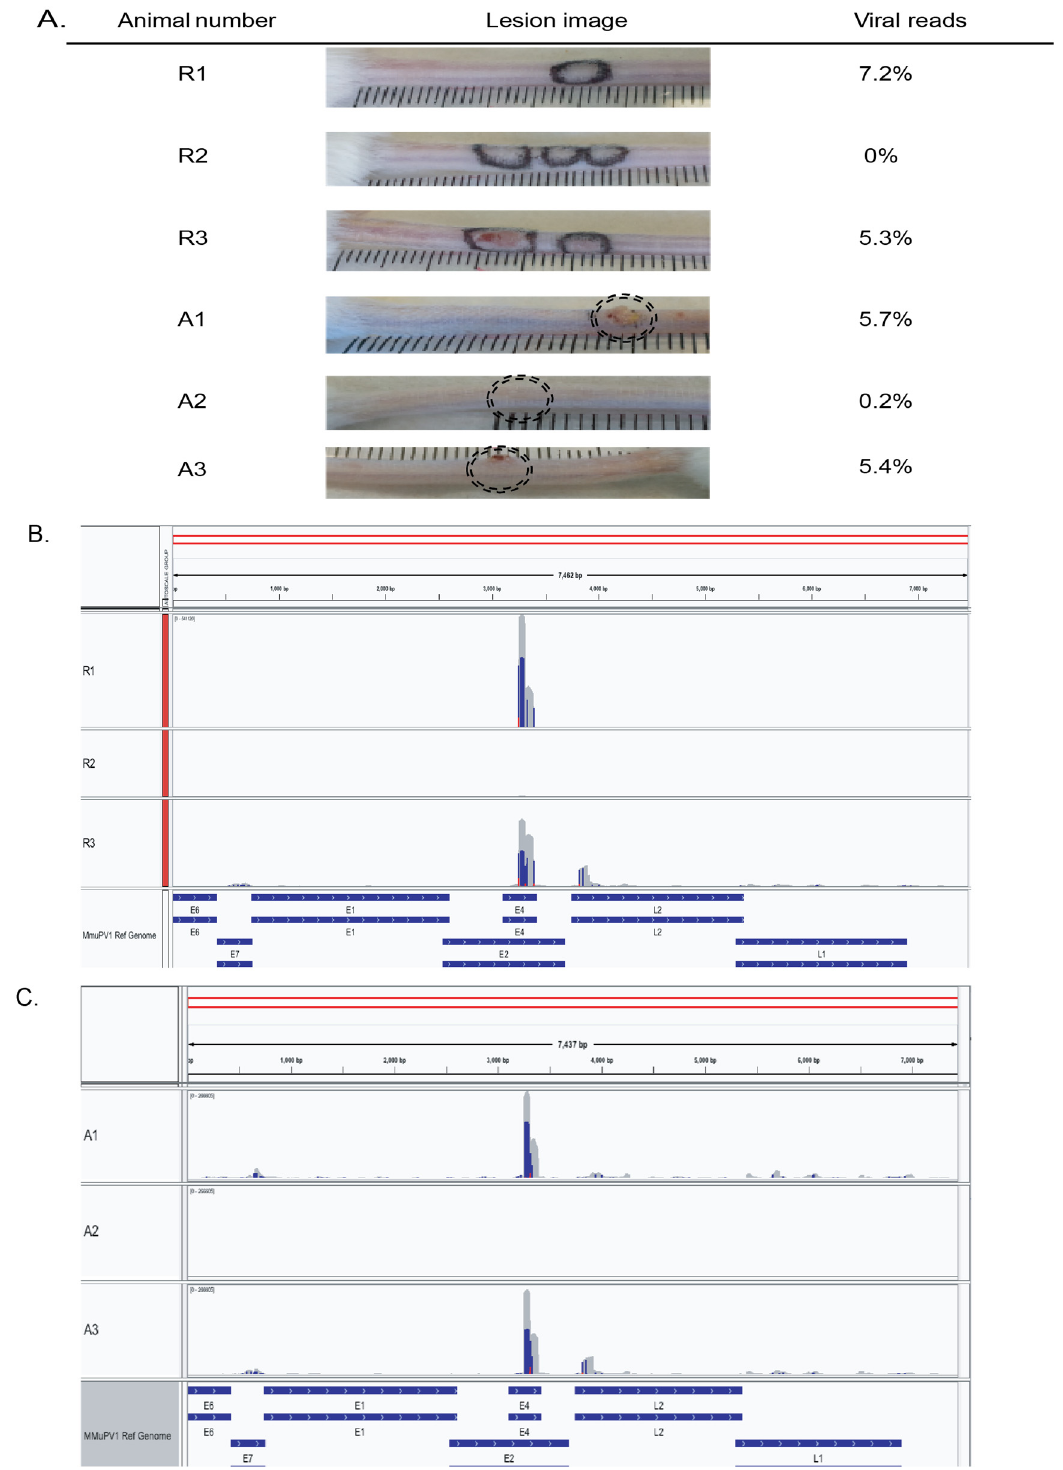
Figure 5. MmuPV1 viral reads within individual samples. ( A ) Images of mouse tails at time of harvest. Marker pen was used to delineate the area of the lesions at the height of infection. ( B , C ) Coverage and distribution of viral reads visualised using IGV software. Coverage depth of reads set to group autoscale for ( B ) regressed (0–266,605) and ( C ) active groups (0–541,120).